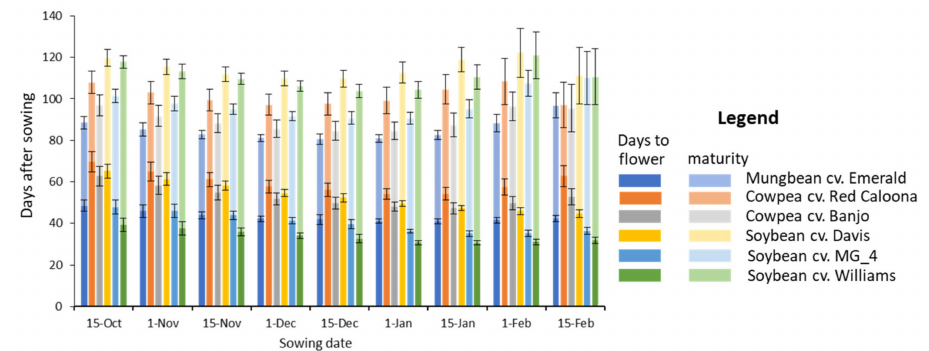
Figure 1. APSIM-predicted phenological development (days to flower and maturity) averaged over long-term simulations (1979–2018, ± standard deviation shown with bars) for mungbean, cowpea and soybean genotypes at one example tropical grain-producing environment (Cecil Plains, Queensland). Similar trends occurred at the other simulated